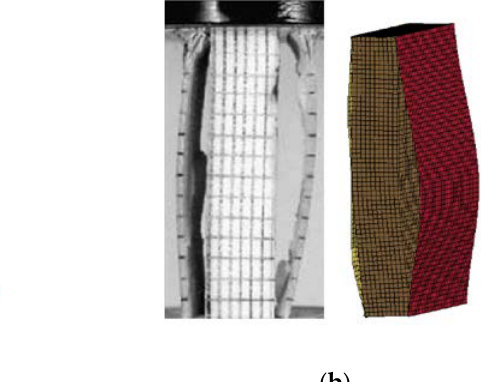
Figure 8. Failure mode with different finite element (FE) model. ( a ) Failure mode of mode Ⅰ [8] and MAT 185 and ( b ) failure mode of mode Ⅱ [8] and tiebreak contact.